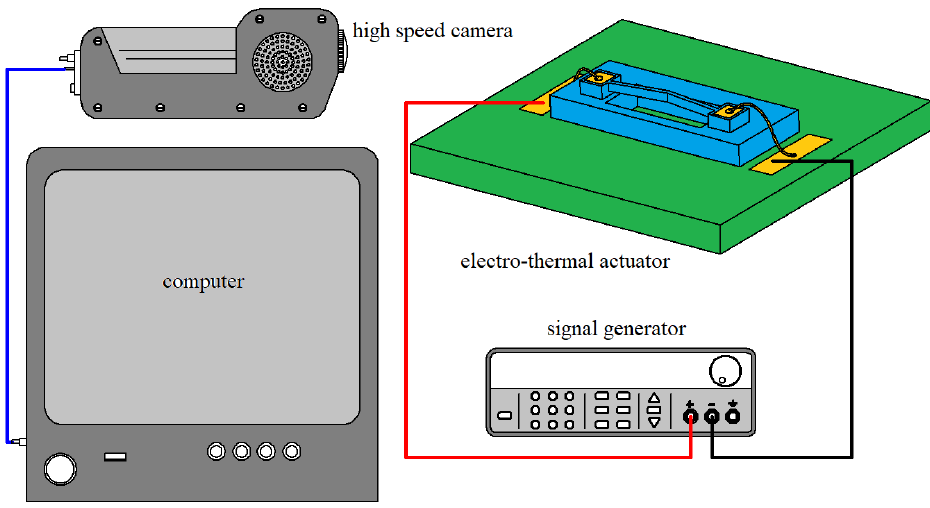
Figure 14. The measurement stage of the response time.